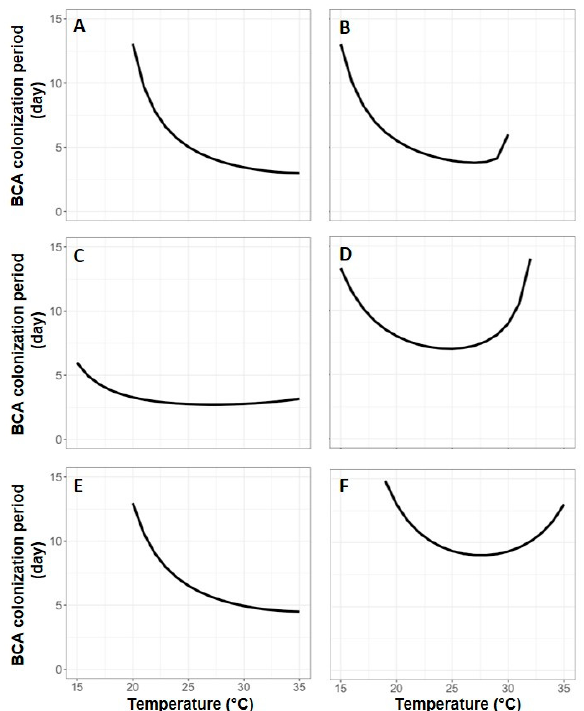
Figure 5. Effect of temperature on the length of the BCA colonization period required by the six BCAs ( A : AMY; B : BOT; C : NOL; D : SER; E : TAE; F : VIN, see Table 1) to attain their maximal colonization of bunch trash. Bunch trash was treated with the BCAs listed in Table 1 and was then incubated in plates at different temperatures and with different RH levels (values in this figure are for RH = 100%); after 1, 3, 6, 9, and 13 days, the number of CFUs was assessed. Lines were drawn using Equation (5) and the parameters listed in Table